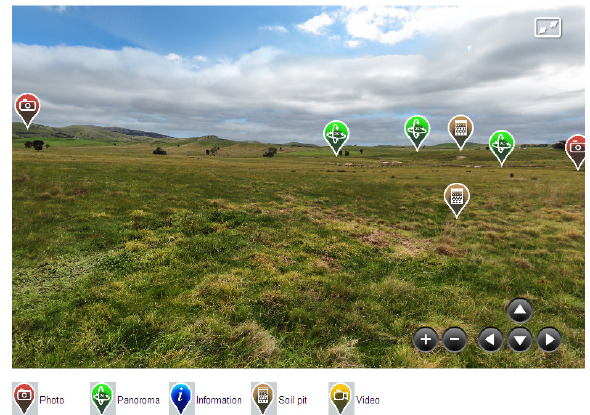
Figure 3. Screen shot of interactive landscape panorama in a sub-catchment of the Bet Bet Creek.